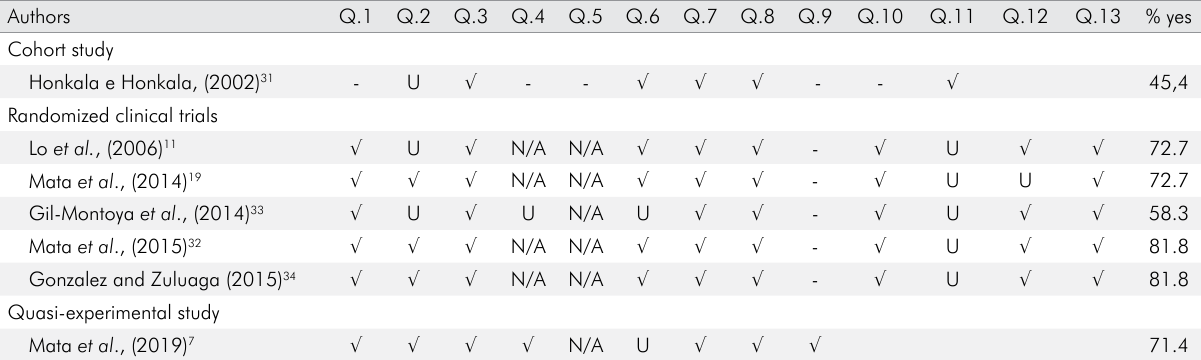
Table 3. Risk of bias assessed by the Joanna Briggs Institute Critical Appraisal Tools for Cohort studies, 35 Randomized Clinical Trials, 36 and Quasi-experimental studies.